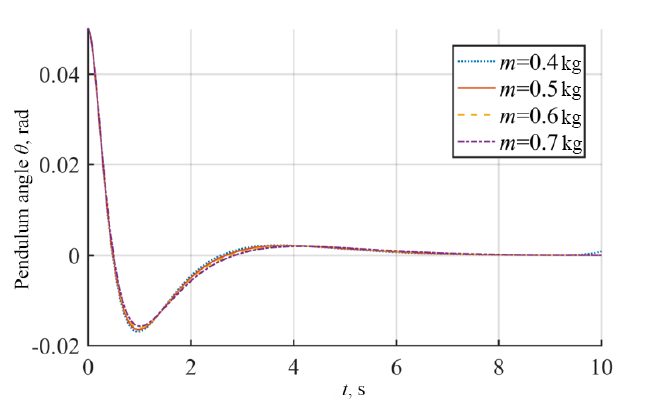
Figure 5. Pendulum angle θ at different m .